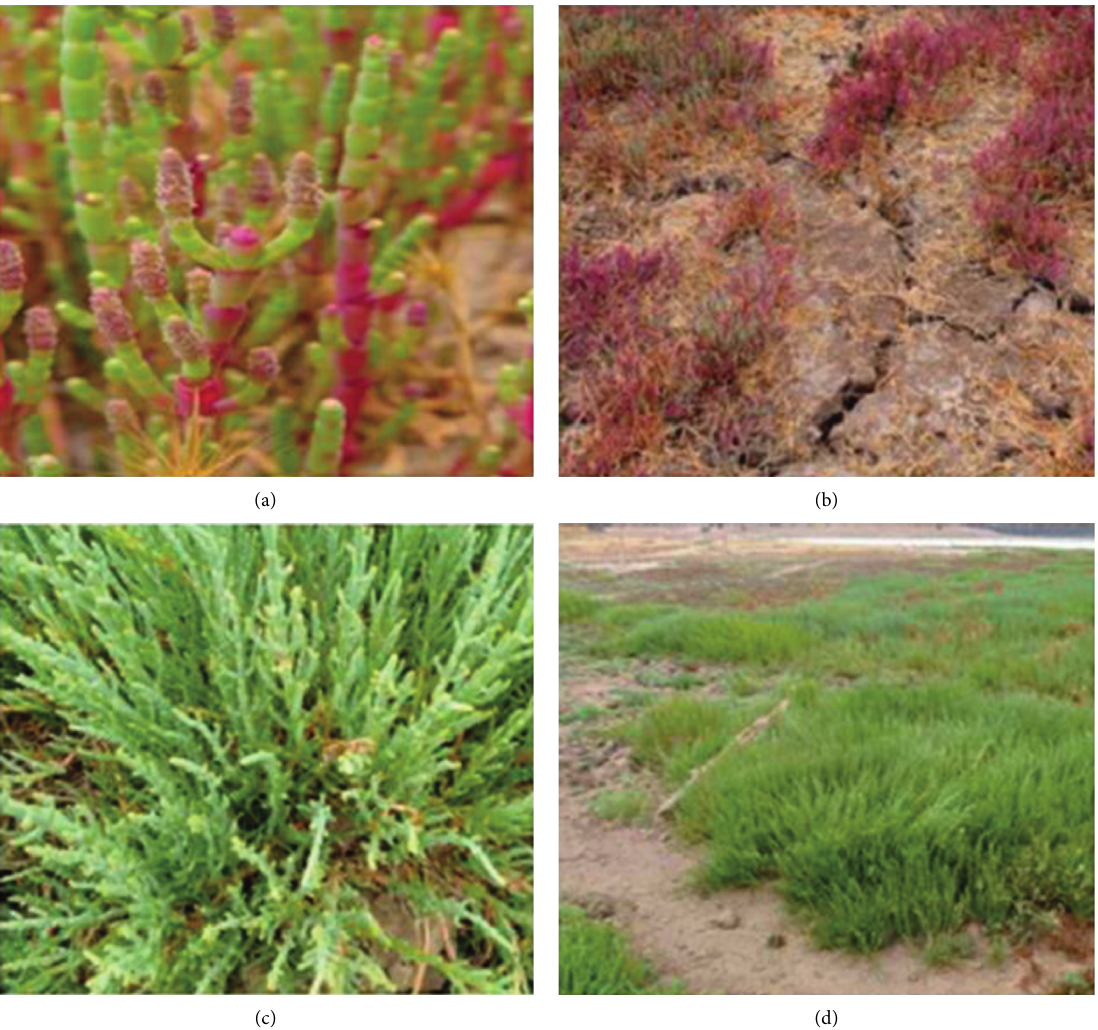
Figure 2: Status and morphology of S. neei in the coastal wetlands of Los Maitenes (a, b) and Matanzas (c,